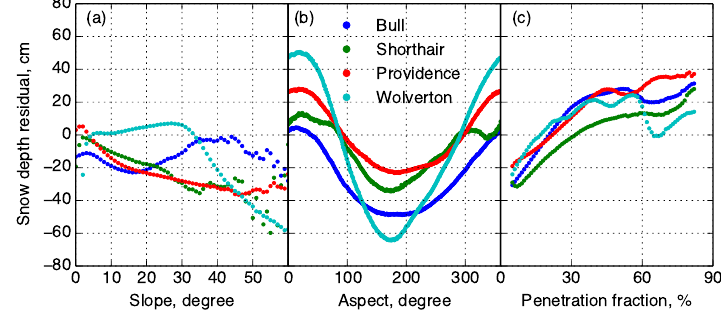
Figure 7. Average snow-depth residual, calculated as difference between lidar-measured snow depth and snow depth from the linear- regression models (open areas), versus (a) slope, (b) aspect and (c) penetration fraction.